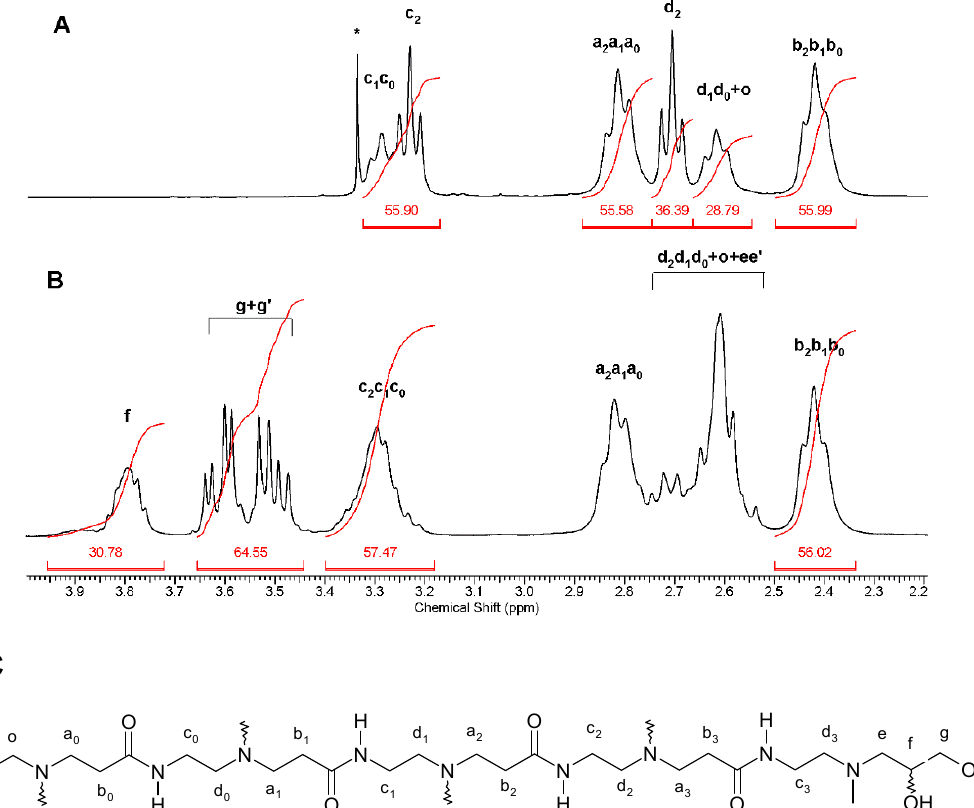
Figure 1. The 1 H NMR spectra of G2 ( A ) and G2 S gl ( B ) in D 2 O. Atom numbering is given in trace ( C ). Methanol resonance at 3.43 is labeled with an asterisk.